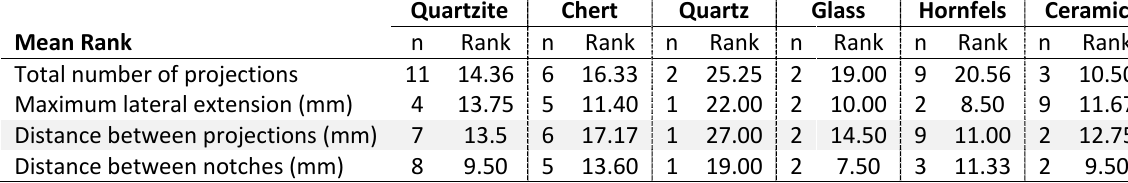
Table 11. Mean rank for projection metrics and raw material groups.